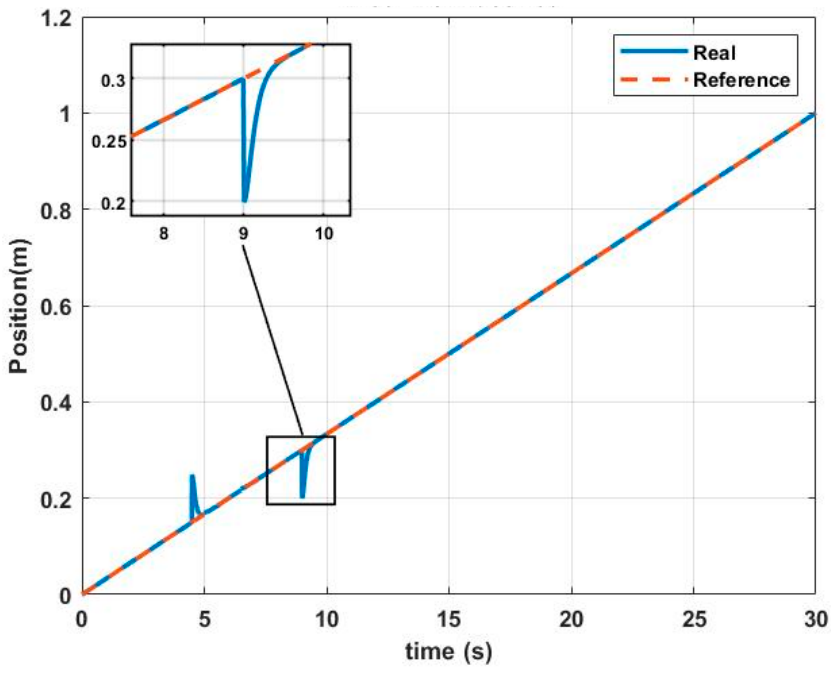
Electronics 2020 , 9 , x FOR PEER REVIEW Figure 17. Z ( 𝐵𝑙𝑢𝑒 𝑆𝑜𝑙𝑖𝑑 𝑙𝑖𝑛𝑒 ) real vs. Z (𝑅𝑒𝑑 𝑑𝑜𝑡𝑡𝑒𝑑 𝑙𝑖𝑛𝑒) desired with perturbance. Figure 17. Z ( Blue Solid line ) real vs. Z ( Red dotted line ) desired with perturbance.